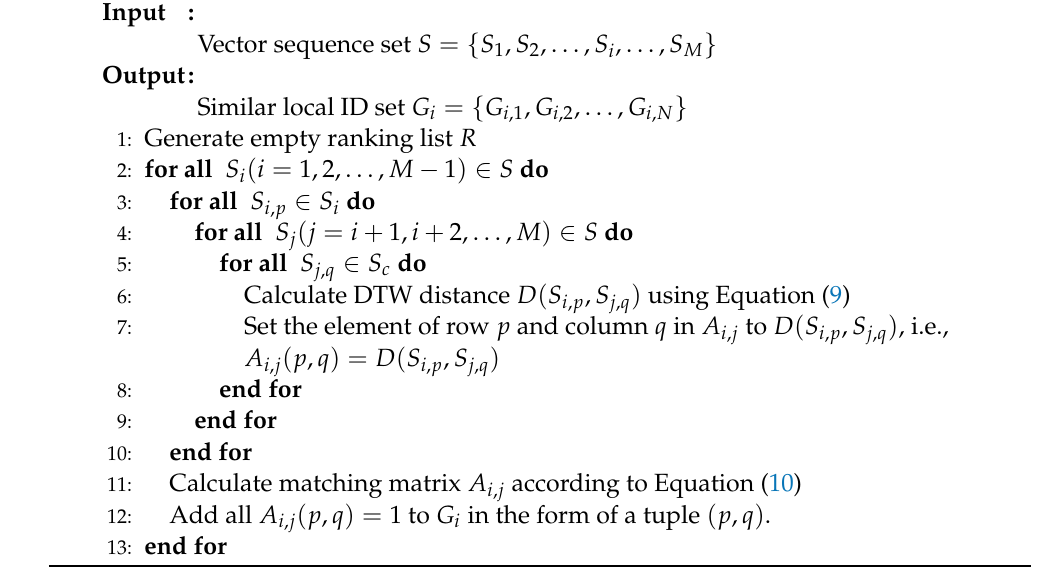
Algorithm 2: Calculation of Similarity List R and Generation of a Global ID List G